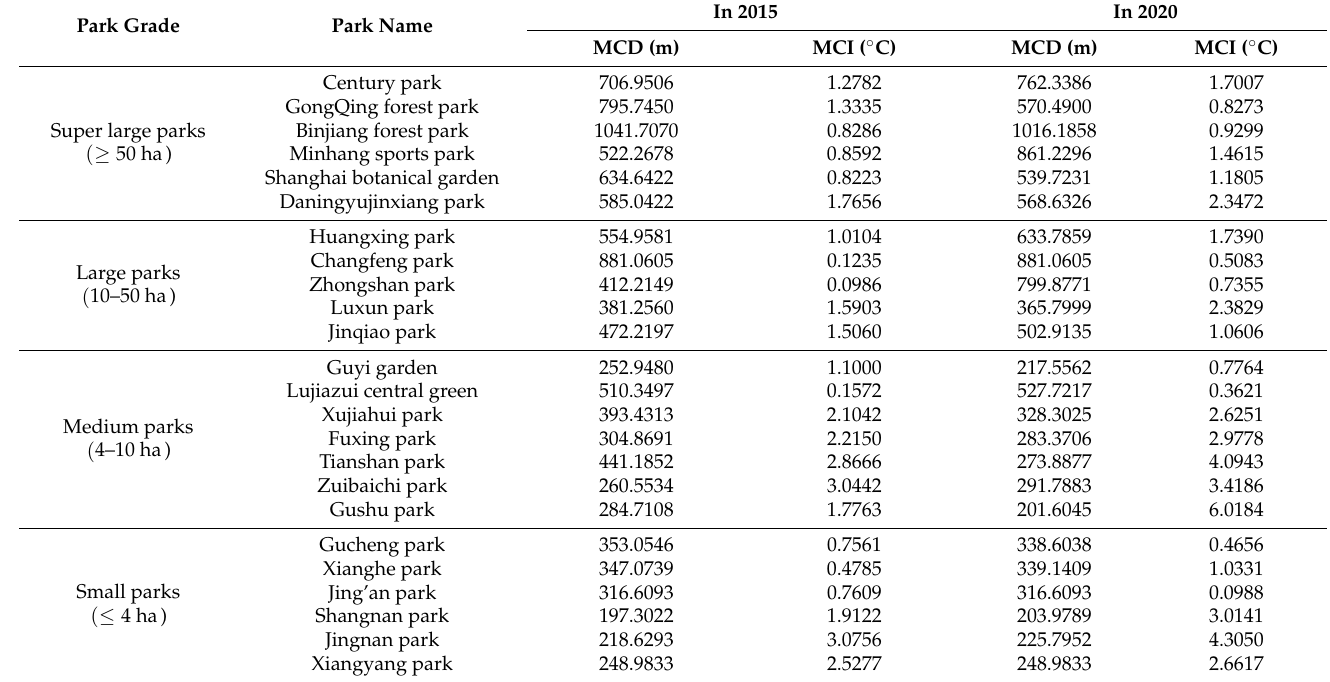
Table 6. Pearson correlation coefficients of park landscape metrics with MCD and MCI.